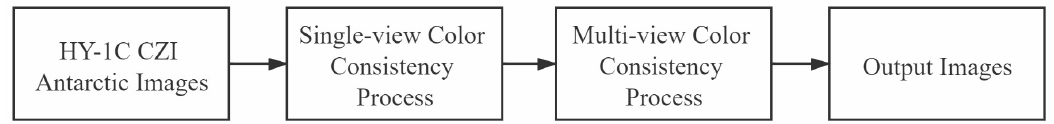
Figure 4. The processing of HY-1C images of Antarctica in the color consistency framework. CZI, Coastal Zone Imager.